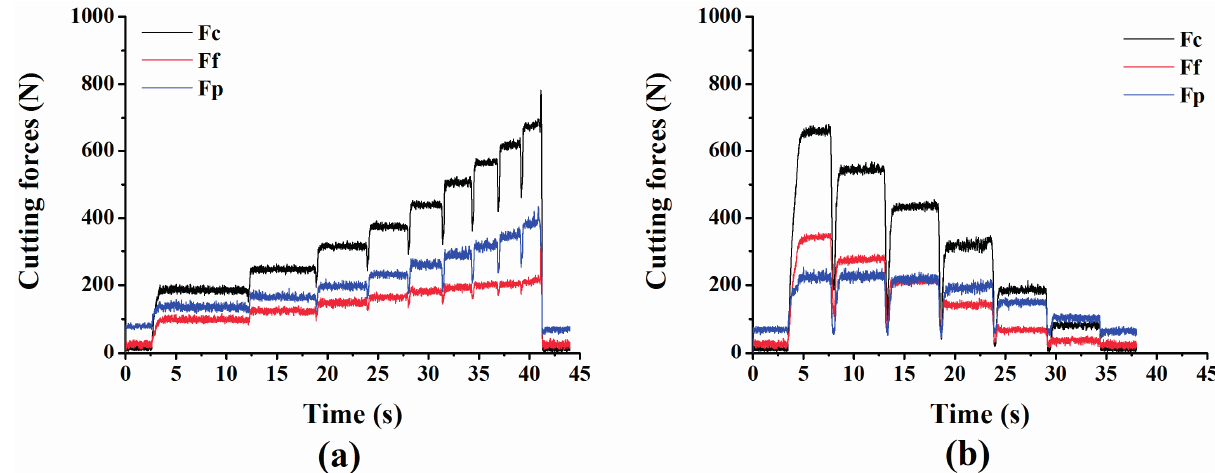
Figure 11. ( a ) Measured cutting force signals in group one; ( b ) Measured cutting force signals in group two.